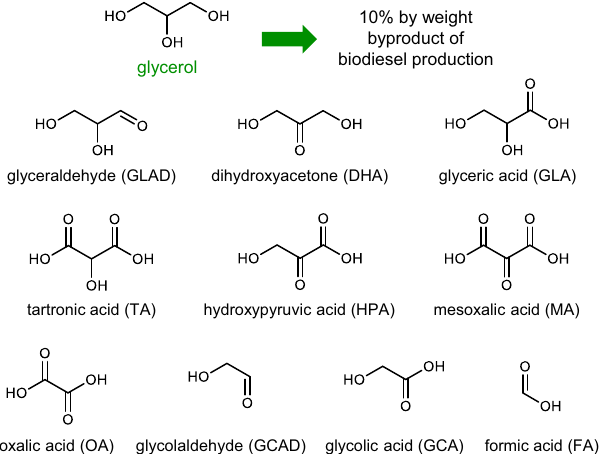
Fig. 1 | Selected products from glycerol oxidation. C1 – C3 molecules that can be obtained from oxidative valorization of glycerol.